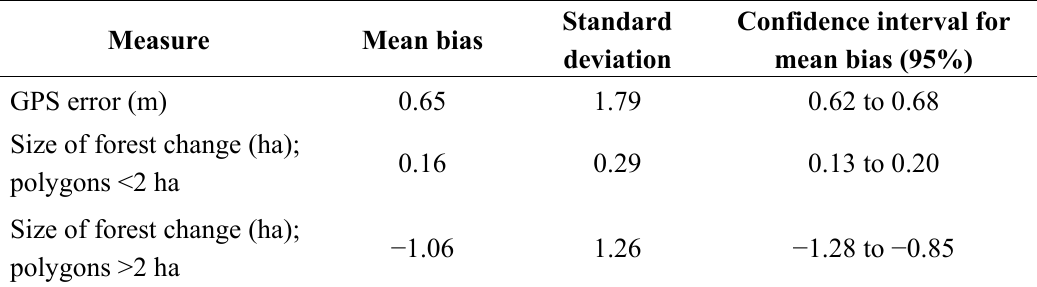
Table 6. Positional accuracy of local expert